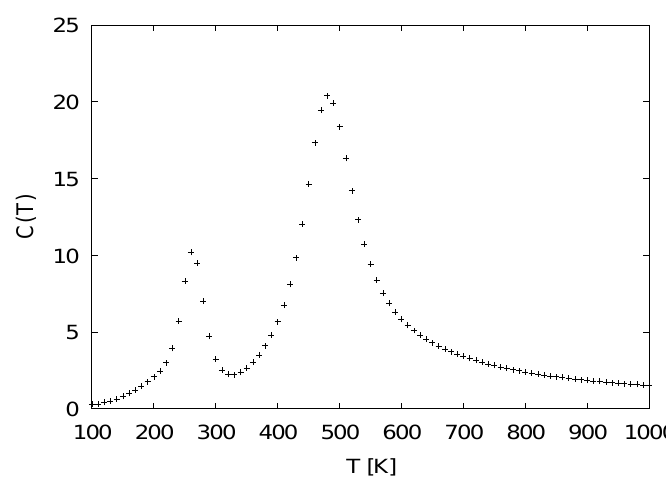
Fig. 3: The specific heat C ( T ) as a function of temperature for Ala